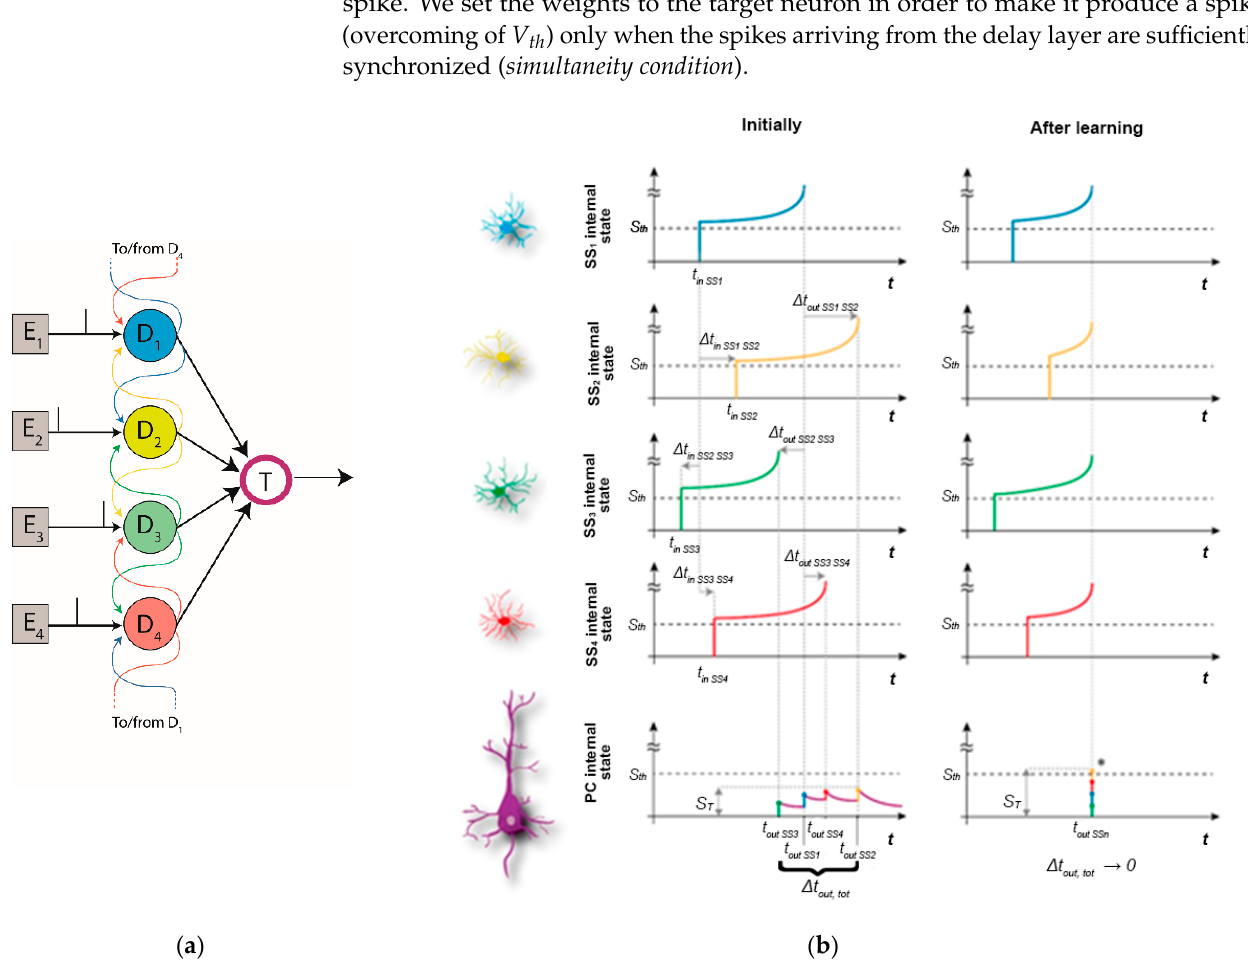
Figure 3. MNSD behavior. ( a ) Diagram of the MNSD architecture. Each circle represents a neuron and the gray boxes represent the input pulse generators. ( b ) Diagram of the operating principle of the MNSD with 4 branches. Δ t in Dm,Dn represents the time difference between the pulses afferent to the delay neurons (i.e., t in Dn − t in Dm ), and Δ t out Dm, Dn the time difference between the pulses afferent to the target neuron (i.e., t out Dn − t out Dm ). On the left, desynchronized input pulses are unable to activate the target; this is because delay neurons fire asynchronously, and the target neuron does not fire due to desynchronization between the arriving spikes (where Δ t out, tot represents the total time interval occupied by the multi-neuronal spike sequence arriving to the target neuron). On the right (after training), thanks to the spike latency modification the delay neurons’ output spikes are generated synchronously ( simultaneity condition: Δ t out, tot → 0) enabling the target activation. Finally, the maximum internal state reached by the target neuron (S T ) is represented for both the cases.